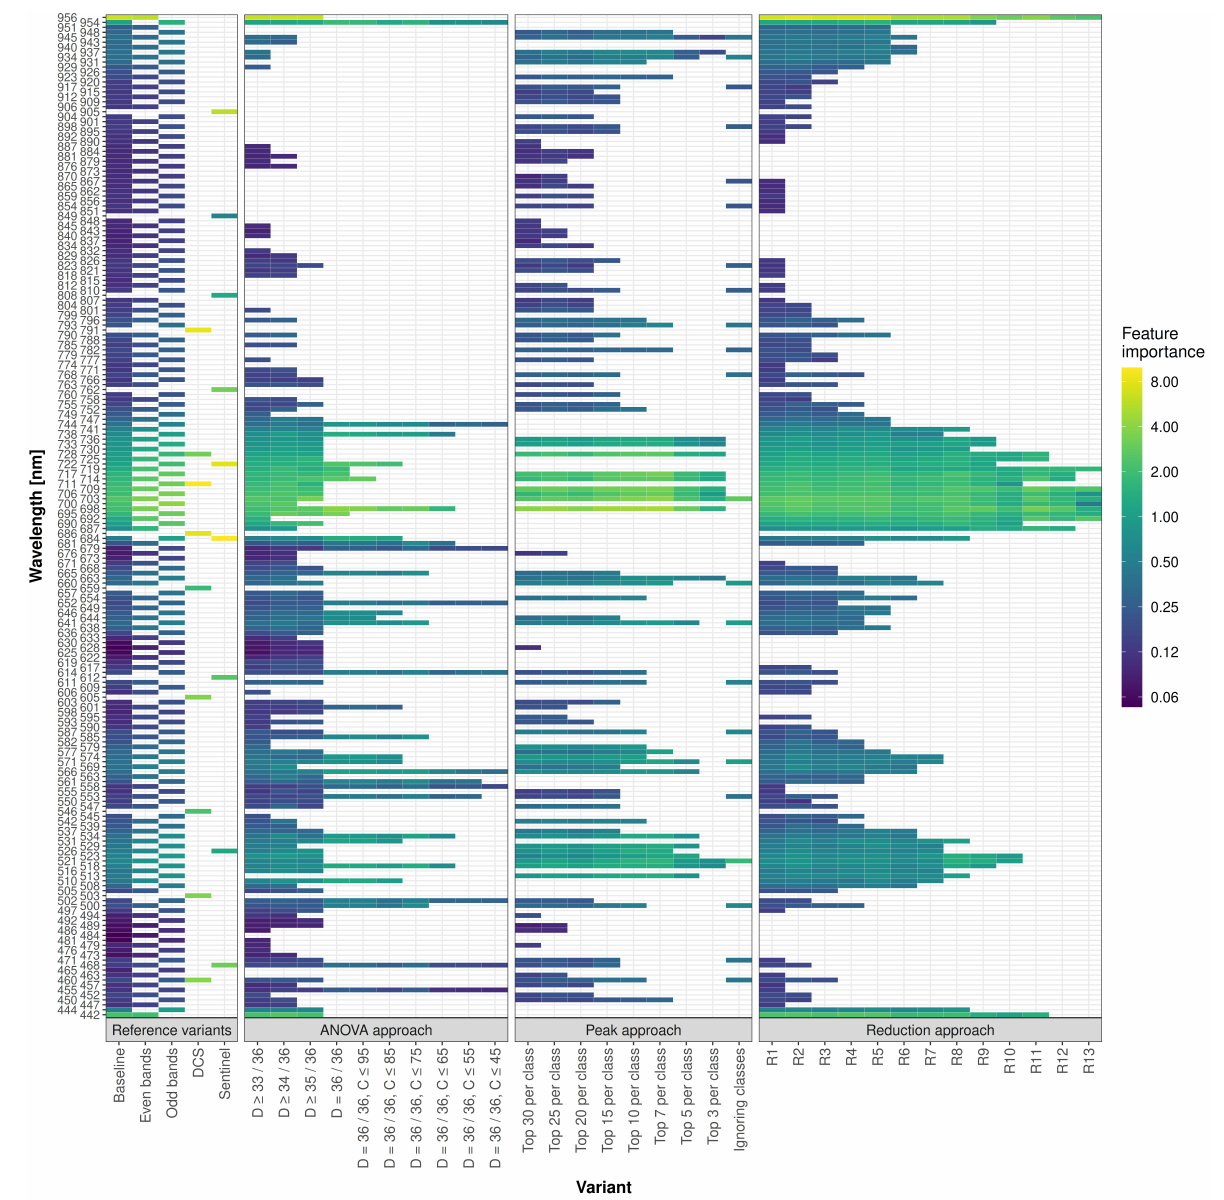
Figure 5. Feature importance for each predictor based on the different variants in different approaches. DCS and Sentinel were mimicked based on their original wavelengths; thus, predictors are not identical with the baseline variant. Note that DCS and Sentinel spectral coverages per underived predictor were substantially higher (Table 2) compared to that of the underived hyperspectral camera (Specim Fx10 predictors with a full width at half maximum (FWHM) ≤